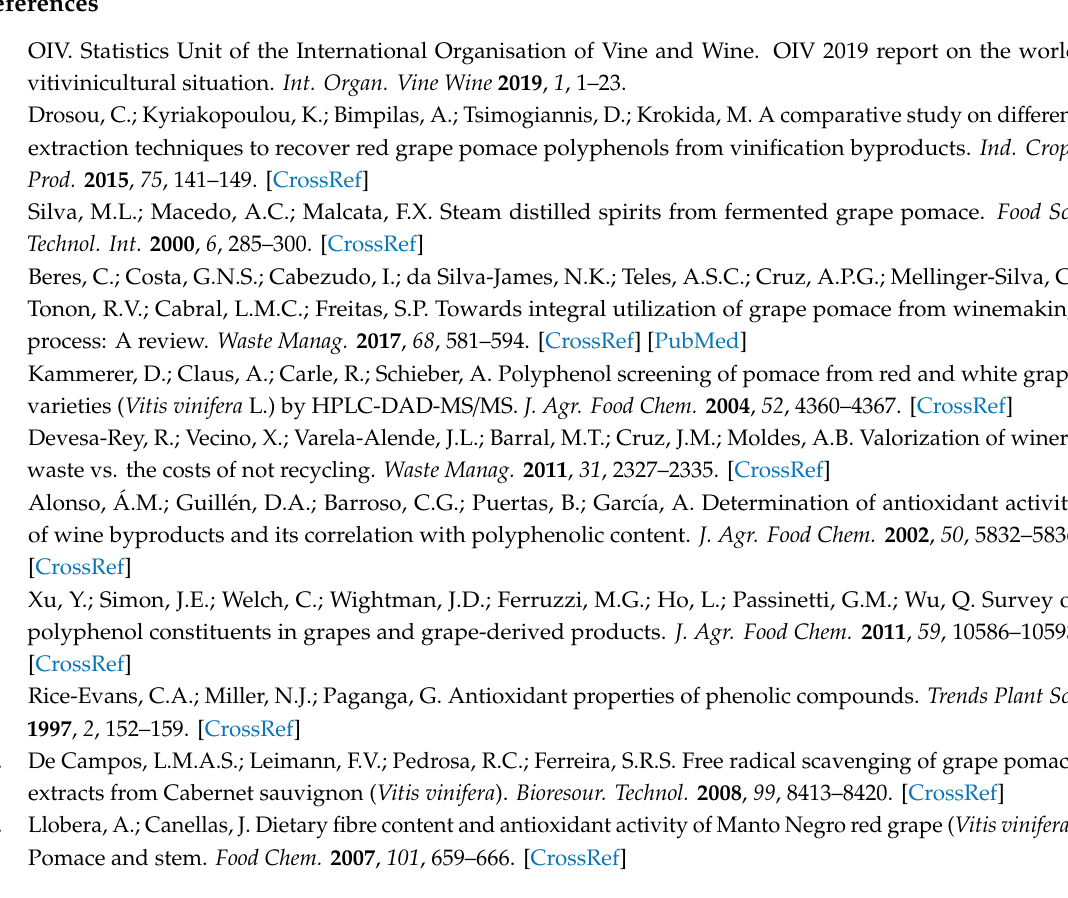
Figure S1: Pure water permeability of the NF90 membrane. W p 0 , water permeability before the red grape pomace extract nanofiltration; W p 1 , water permeability after the red grape pomace extract; and W p 2 , water permeability after cleaning with water (operating conditions—feed flowrate of 0.8 L / min; Tof 25 ± 1 ◦ C); Figure S2: Pure water permeability of the CA316 membrane. W p 0 , water permeability before the treatment of red grape pomace extract; W p 1 , water permeability after the treatment of red grape pomace extract; and W p 2 , water permeability after cleaning with water (operating conditions—feed flowrate, 0.8 L / min; T, 25 ± 1 ◦ C); Figure S3: Pure water permeability of the CA316-70 membrane. W p 0 , water permeability before the treatment of red grape pomace extract; W p 1 , water permeability after the treatment of red grape pomace extract; and W p 2 , water permeability after cleaning with water (operating conditions—feed flowrate, 0.8 L / min; T, 25 ± 1 ◦ C); and Figure S4: Pure water permeability of the CA400-22 membrane. W p 0 , water permeability before the treatment of red grape pomace extract; W p 1 , water permeability after the treatment of red grape pomace extract; and W p 2 , water permeability after cleaning with water (operating conditions—feed flowrate, 0.8 L / min; T, 25 ± 1 ◦